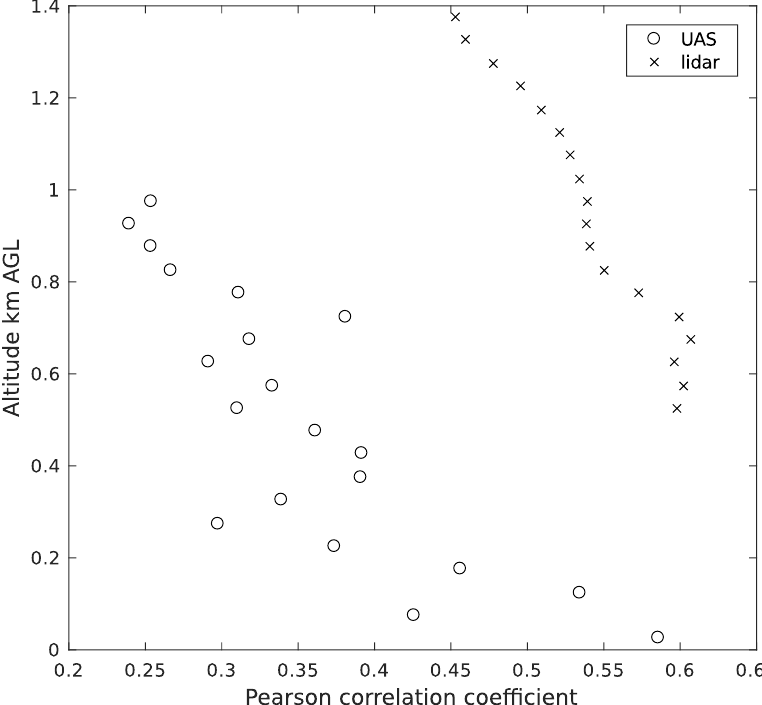
Figure 15. Change of Pearson correlation coefficient with altitude for 1) absorption coefficient measured on ground by AE-31 and absorption coefficient measured by AE-51 on the UAS, 2) extinction coefficient retrieved from lidar